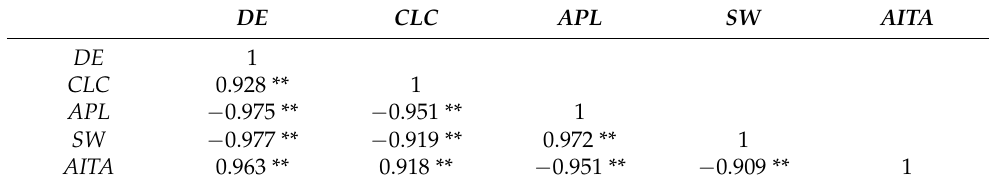
Table 3. The correlation coefficients between the global measurements and performance indicator.